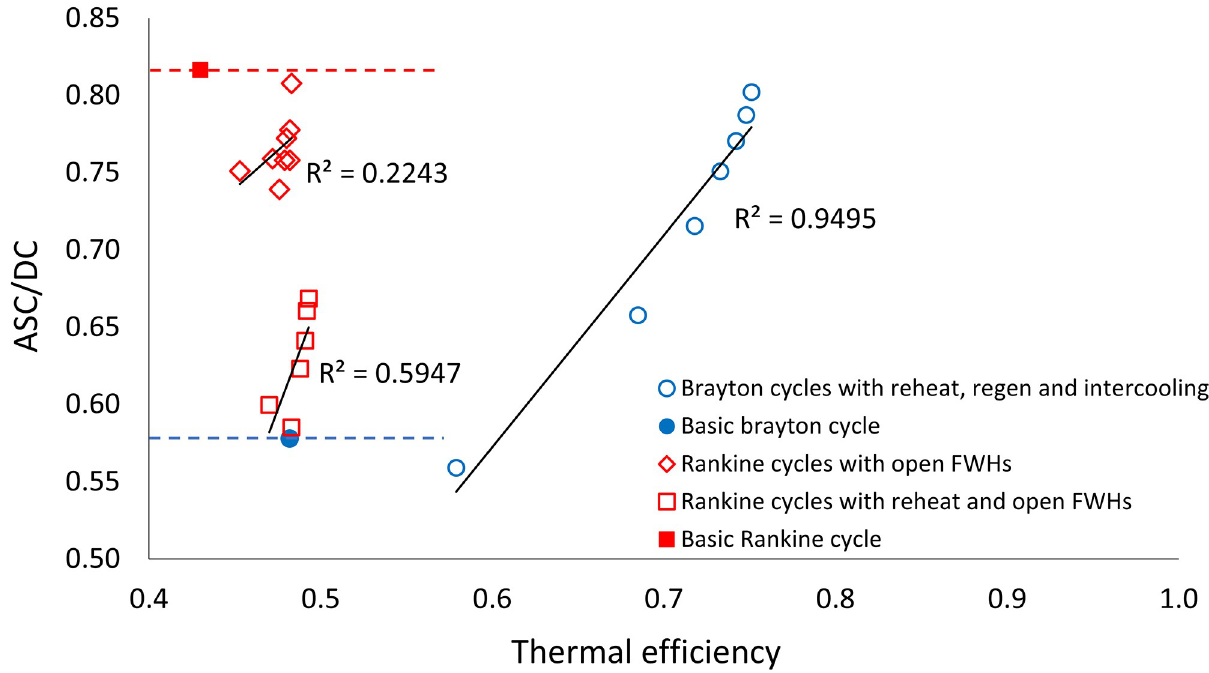
Fig 4. Thermal efficiency plotted against the ratio ASC/DC for the three sets of thermodynamic cycle improvements. The ASC/DC values of the basic Brayton and Rankine cycles are highlighted by the red and blue dotted lines.